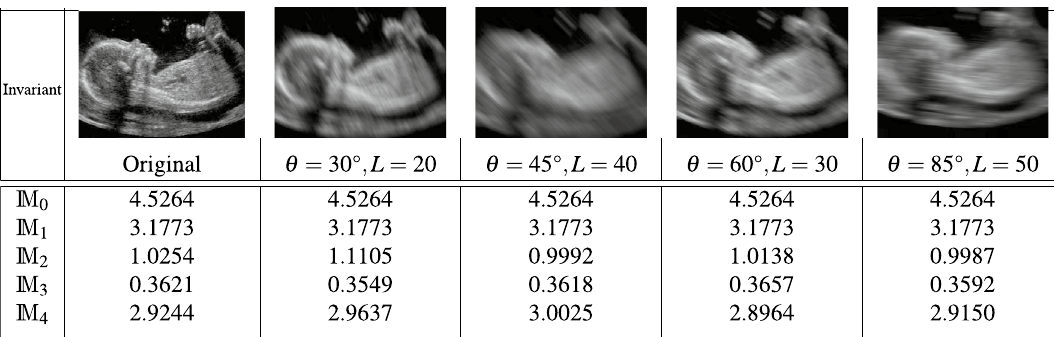
Table 3. The values of the geometric moment invariants with different motion blur parameters of angle/length. M r shows the invariant value of the moment order r , as discussed in “Motion blur invariant in moment domain”